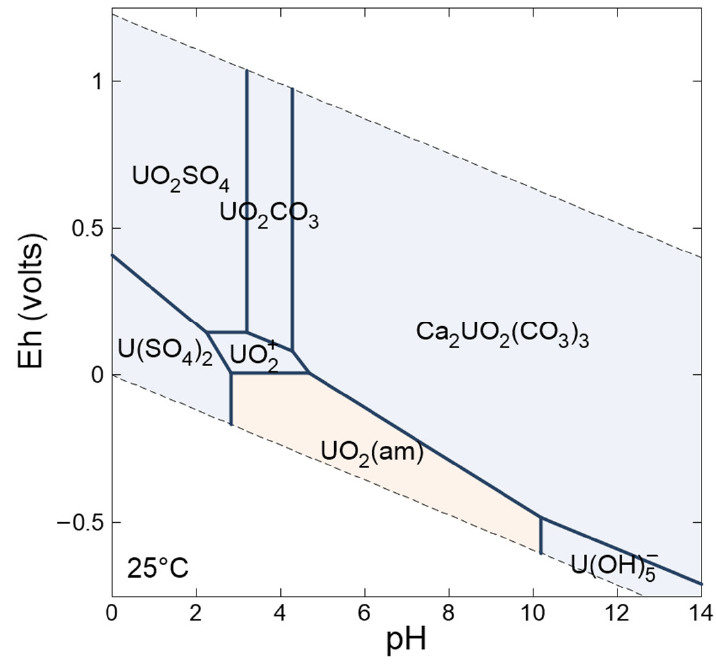
Figure A29. Low uranium 1 mg/L, Ca 5 mM (200 mg/L), bicarbonate 7 mM (427 mg/L), sulfate 4 mM (384 mg/L), and chloride 2 mM (71 mg/L).